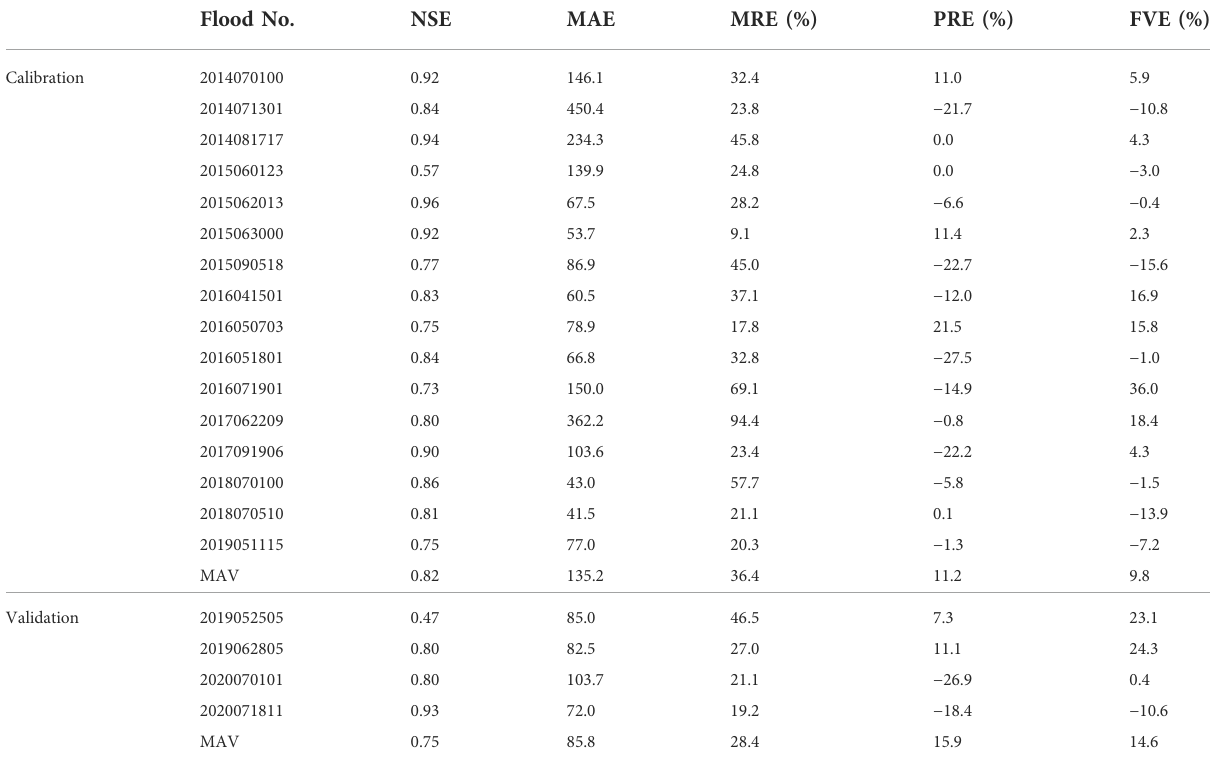
TABLE 8 Simulation error statistics of the XAJ model optimized by the CSCE. Flood No. NSE MAE MRE (%) PRE (%) FVE (%) Calibration 2014070100